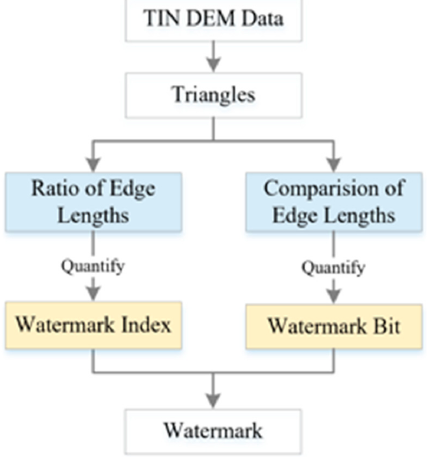
Figure 1. The framework of the proposed method.